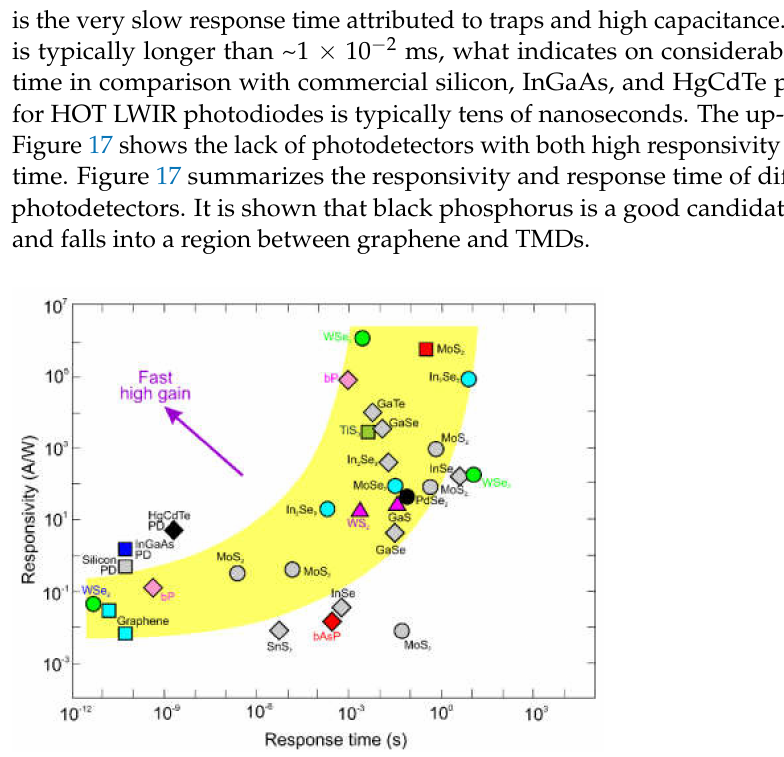
Figure 17. Current responsivity versus response time for HOT 2D material photodetectors in re- lation to the commercial silicon, InGaAs and HgCdTe detectors (experimental data taken from reference